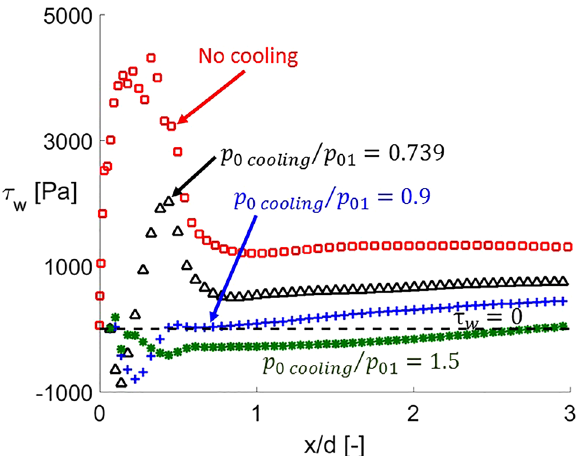
Figure 8. Wall shear stress distributions at the leading edge region under different cooling injection total pressures.